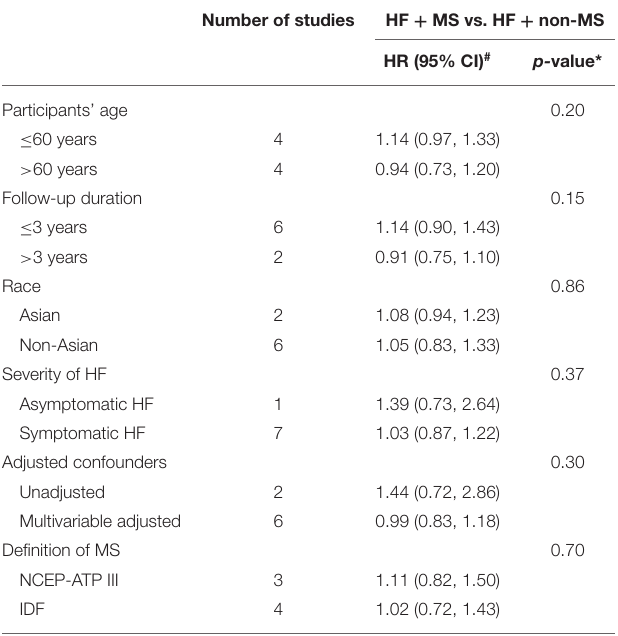
TABLE 2 | Subgroup analyses of the association between MS and risk of all-cause mortality in HF patients. Number of